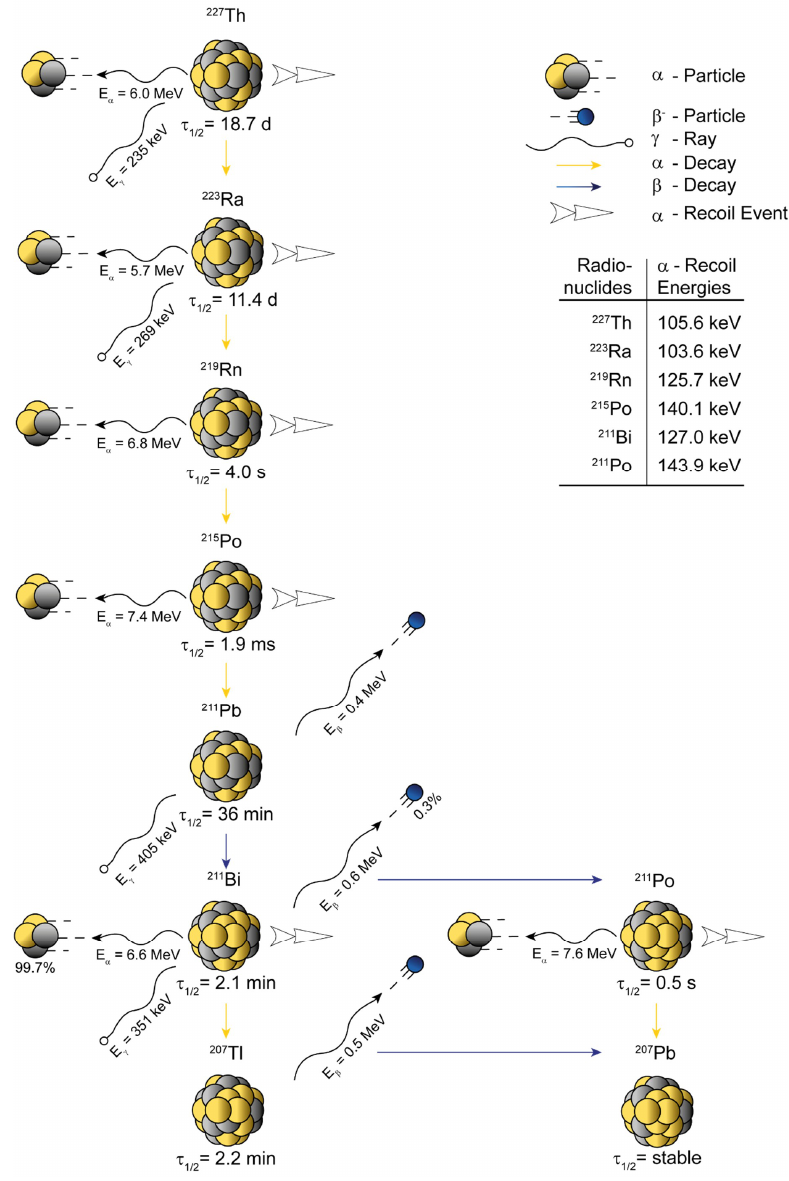
Figure 2. Schematic representation of the atomic in vivo nanogenerator 227 Th (τ ½ = 18.7 d, E α = 6.0 MeV). 227 Th decays through five net α-disintegrations (six in total) and two net β – -disintegrations (three in total) into stable 207 Pb. 227 Th possess at least four eligible γ -emissions for detection, 235 keV (I = 12.9%, 227 Th), 269 keV (I = 13.9%, 223 Ra), 405 keV (I = 3.8%, 211 Pb), and 351 keV (I = 13.0%, 211 Bi). The most = 11.4 d, E = 6.3 MeV), which is also used for TAT prominent daughter radionuclide is 223 Ra ( τ 1 α 2 itself. The half-life ( τ 1 ), known energies connected to recoil events (translational kinetic energy E t ), 2 and the decay energies (E α , E β , E γ ) are indicated on the scheme. Data were derived from Nucleonica GmbH, Nuclide Datasheets, Nucleonica Nuclear Science Portal (www.nucleonica.com), Version 3.0.65, Karlsruhe